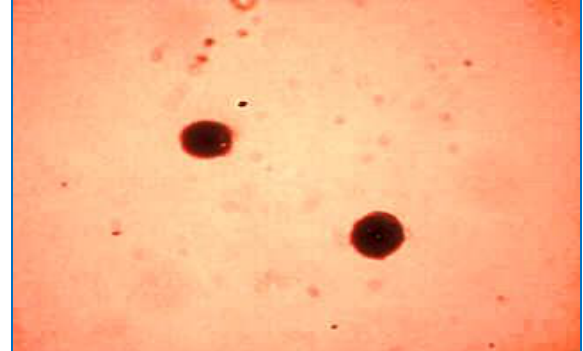
Figure, h: Cryptosporidium sp. oocyst in stray dogs.